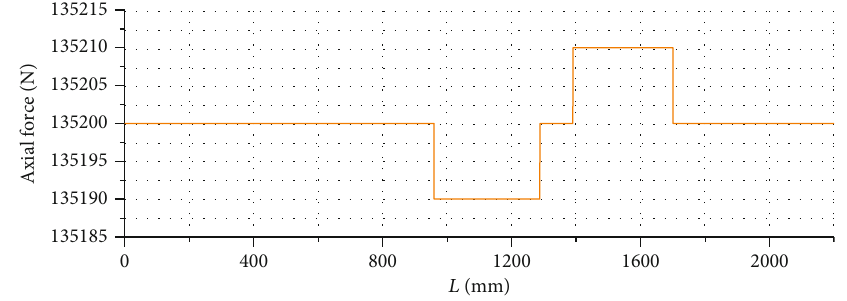
Figure 9: Axial force diagram when the gross load is